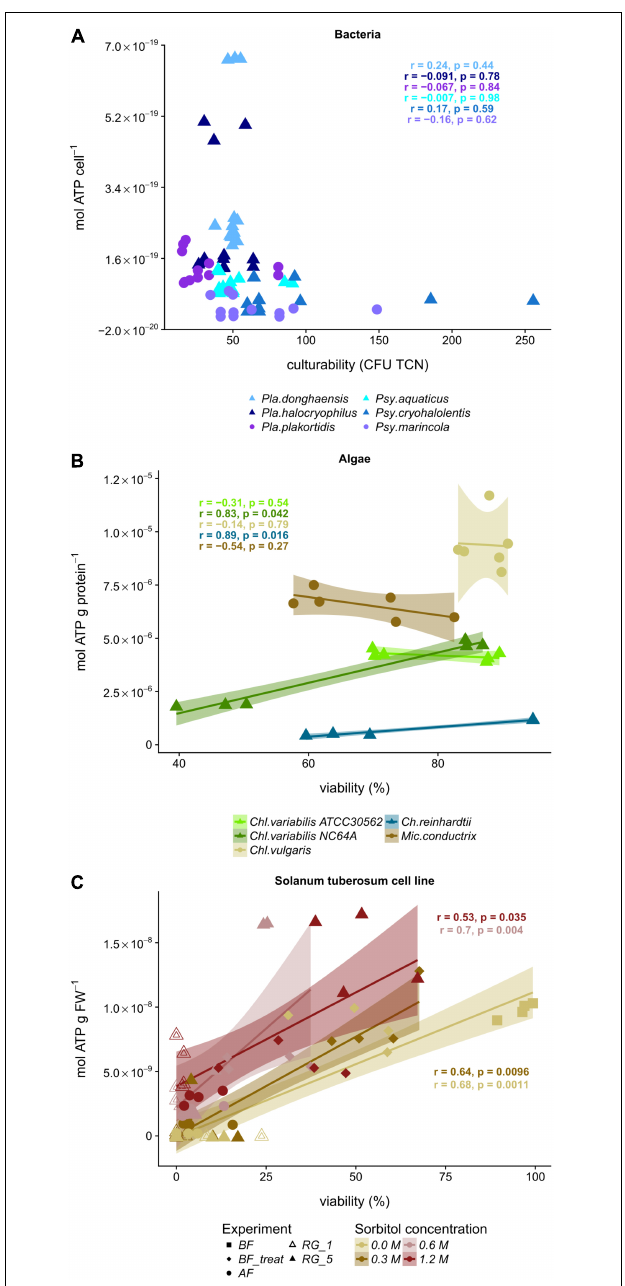
FIGURE 4 | Correlation of ATP levels and viability during freezing of bacteria, green algae and a plant cell line. (A) Depicted is the ATP content vs. culturability (CFU, colony forming units per TCN, total cell numbers) of the different bacterial strains ( Pla ., Planococcus , Psy ., Psychrobacter ). (B) ATP content vs. viability with 95% confidence interval and linear regression of the green algae Ch ., Chlamydomonas ; Chl ., Chlorella, and Mic .,